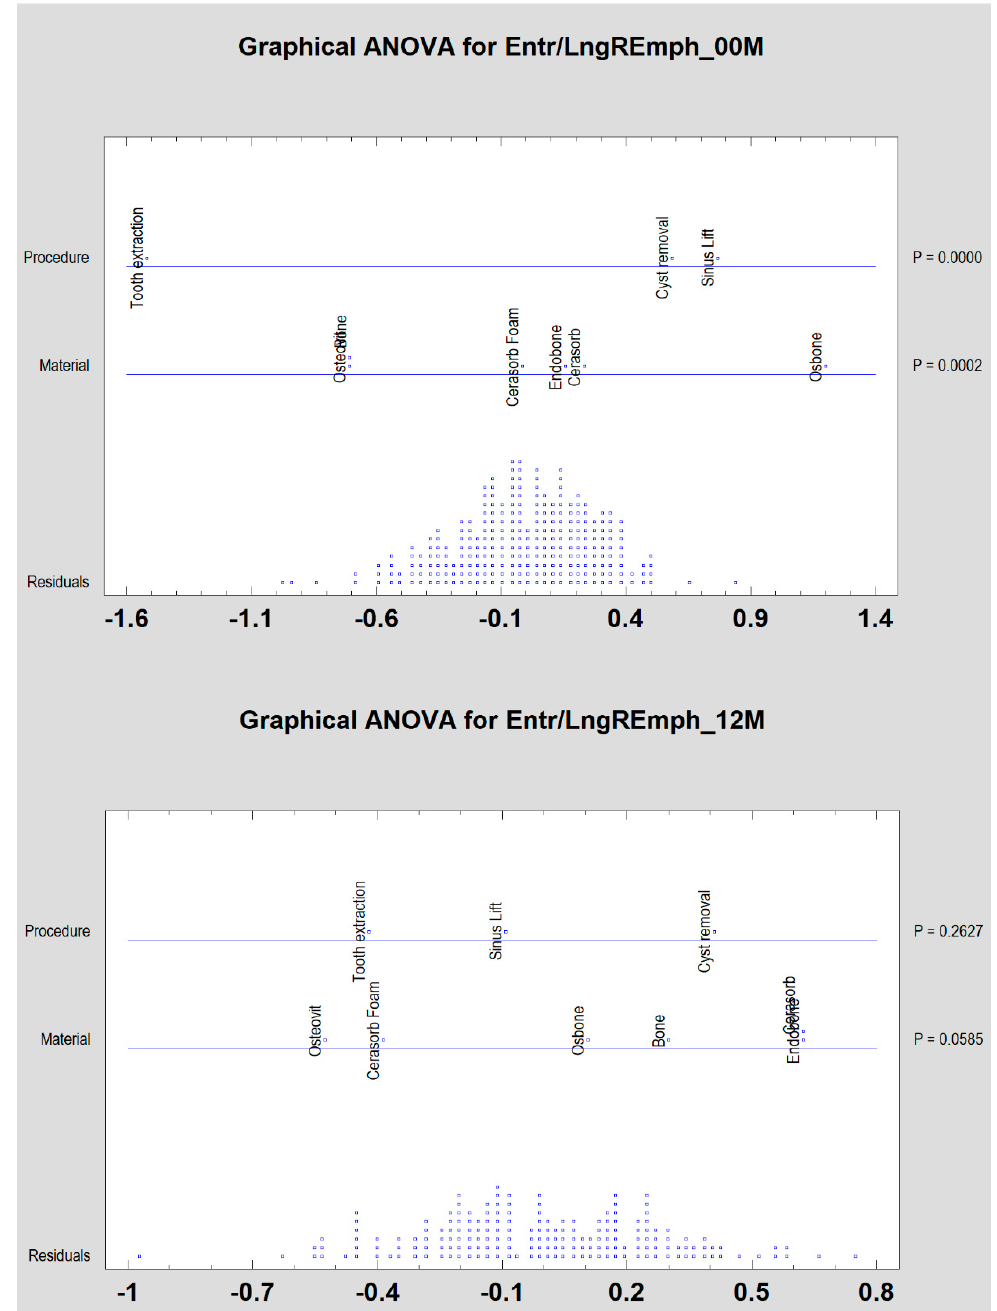
Figure 5. Bone substitute-dependent alteration of radiotexture defined by the texture index in the implantation site depending on surgical procedure. Observation immediately (00M) and 12 months post-operation (12M).